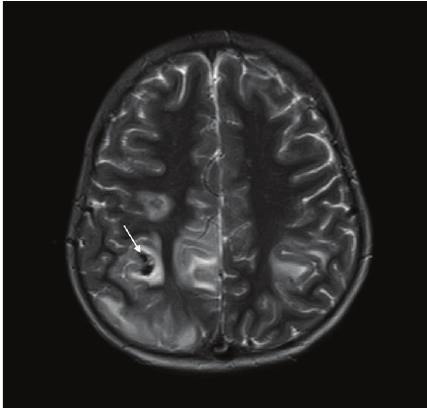
Figure 4: MR venogram showing absent flow signal in superior sagittal sinus